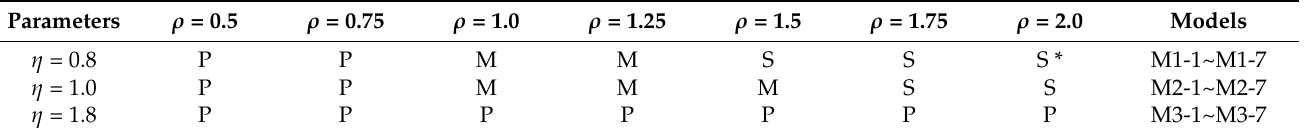
Table 3. Comparison of failure modes of all models ( σ = 0.3